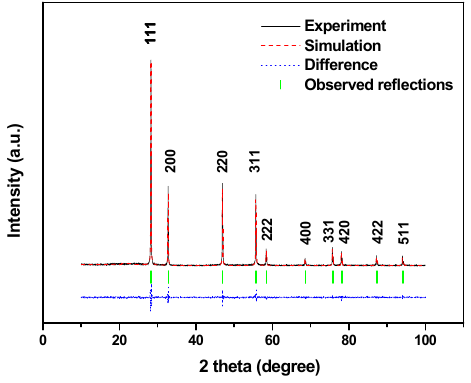
Figure 1. X-ray powder diffraction patterns and Rietveld refinements of BiGdO 3 . A difference (observed-calculated) profile is shown beneath. The tic marks represent reflection positions.